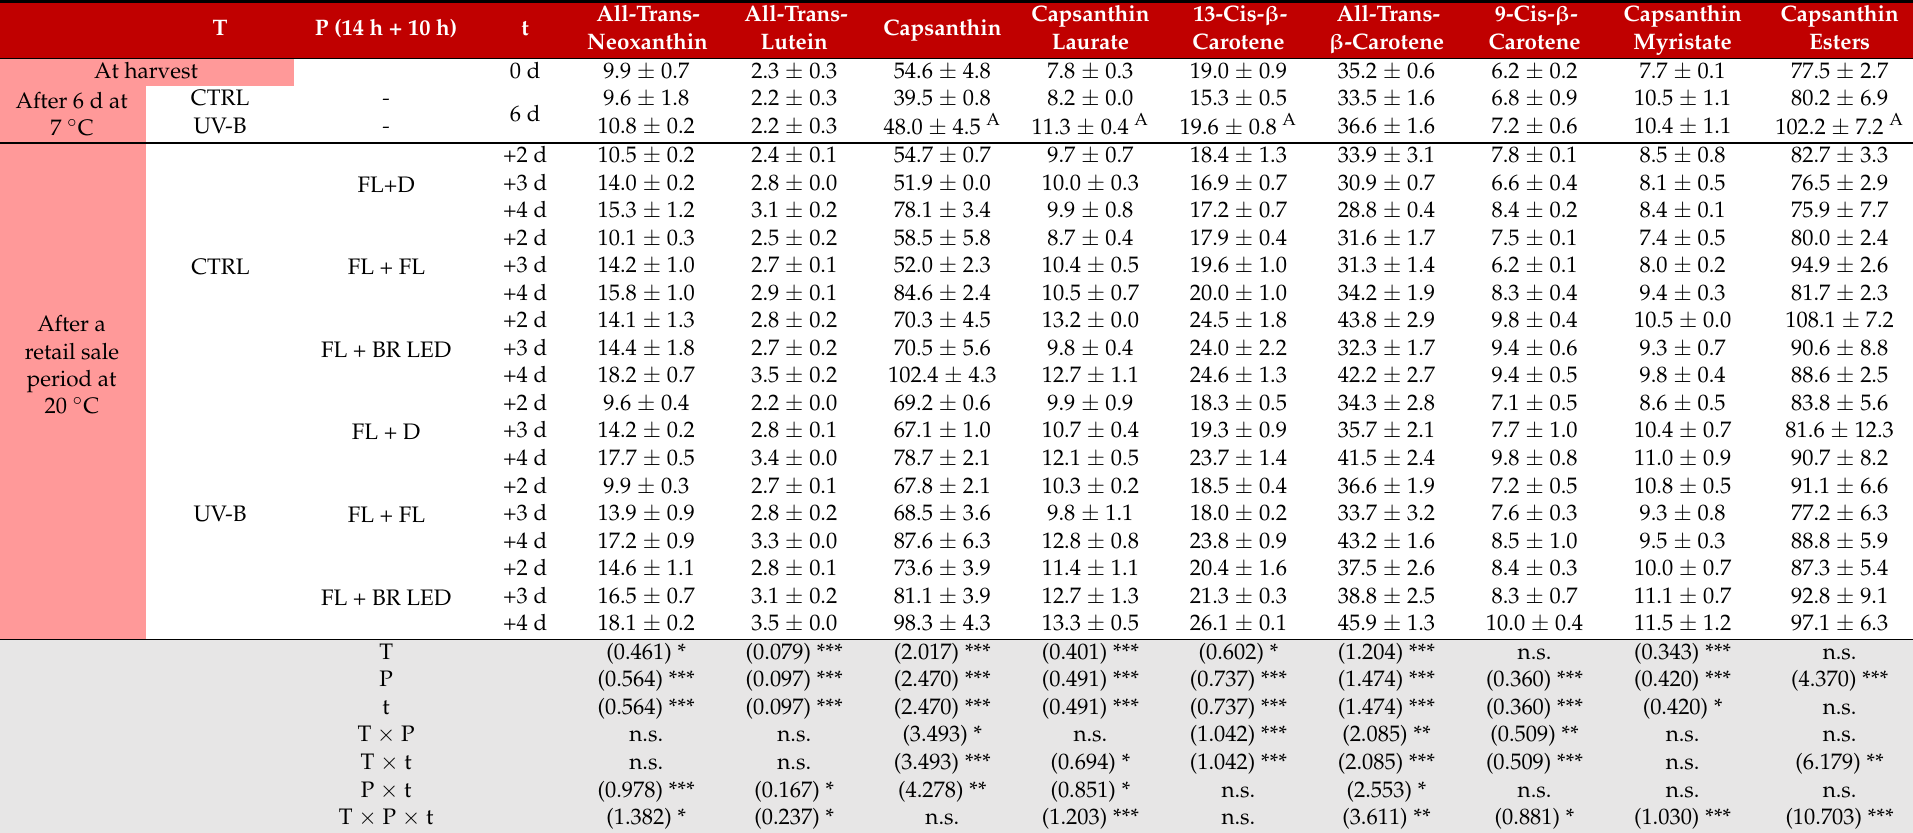
Table 4. Individual carotenoid content (mg β -carotene kg − 1 ) of UV-B-treated and untreated (CTRL) bell peppers during a storage and transportation period of 6 d at 7 ◦ C followed by a retail sale period of 2, 3, or 4 d at 20 ◦ C under a photoperiod of 14 h in fluorescent light + 10 h in different light